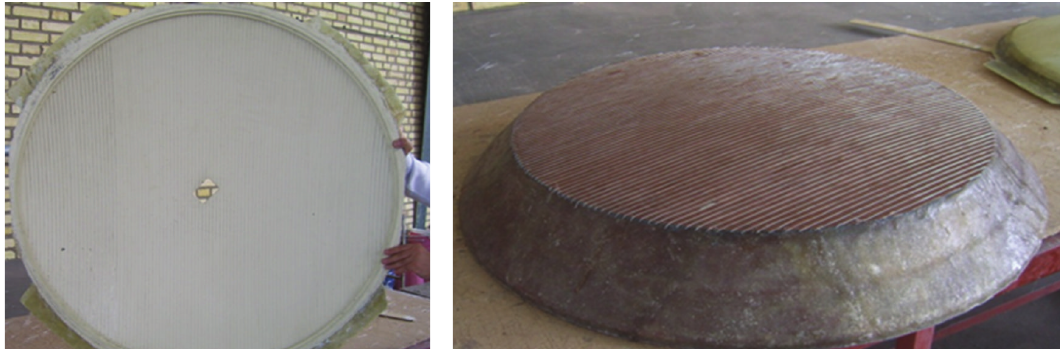
Figure 5: Manufacturing